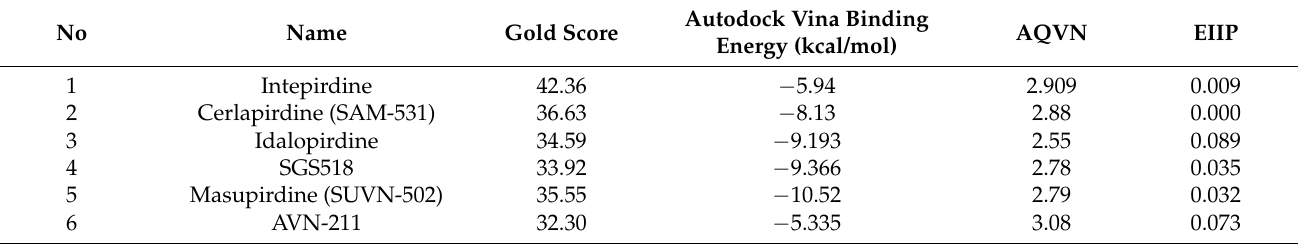
Table 1. List of literature compounds for 5HT6 receptor, with their docking